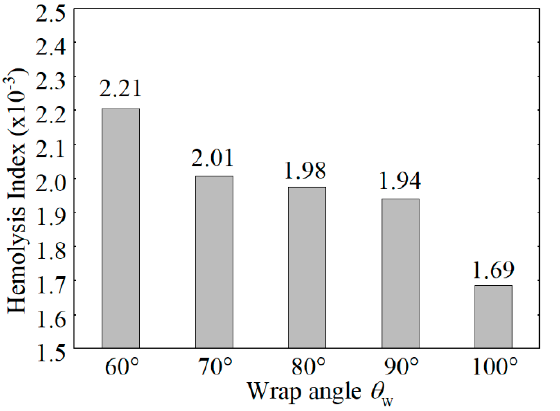
Figure 12. Hemolysis index of 5 test pumps ( θ t = 55°) at the original design point by CFD simulation ( Q 0 = 5.0 L/min, n = 2500 r/min). ( Q 0 = 5.0 L/min, n = 2500